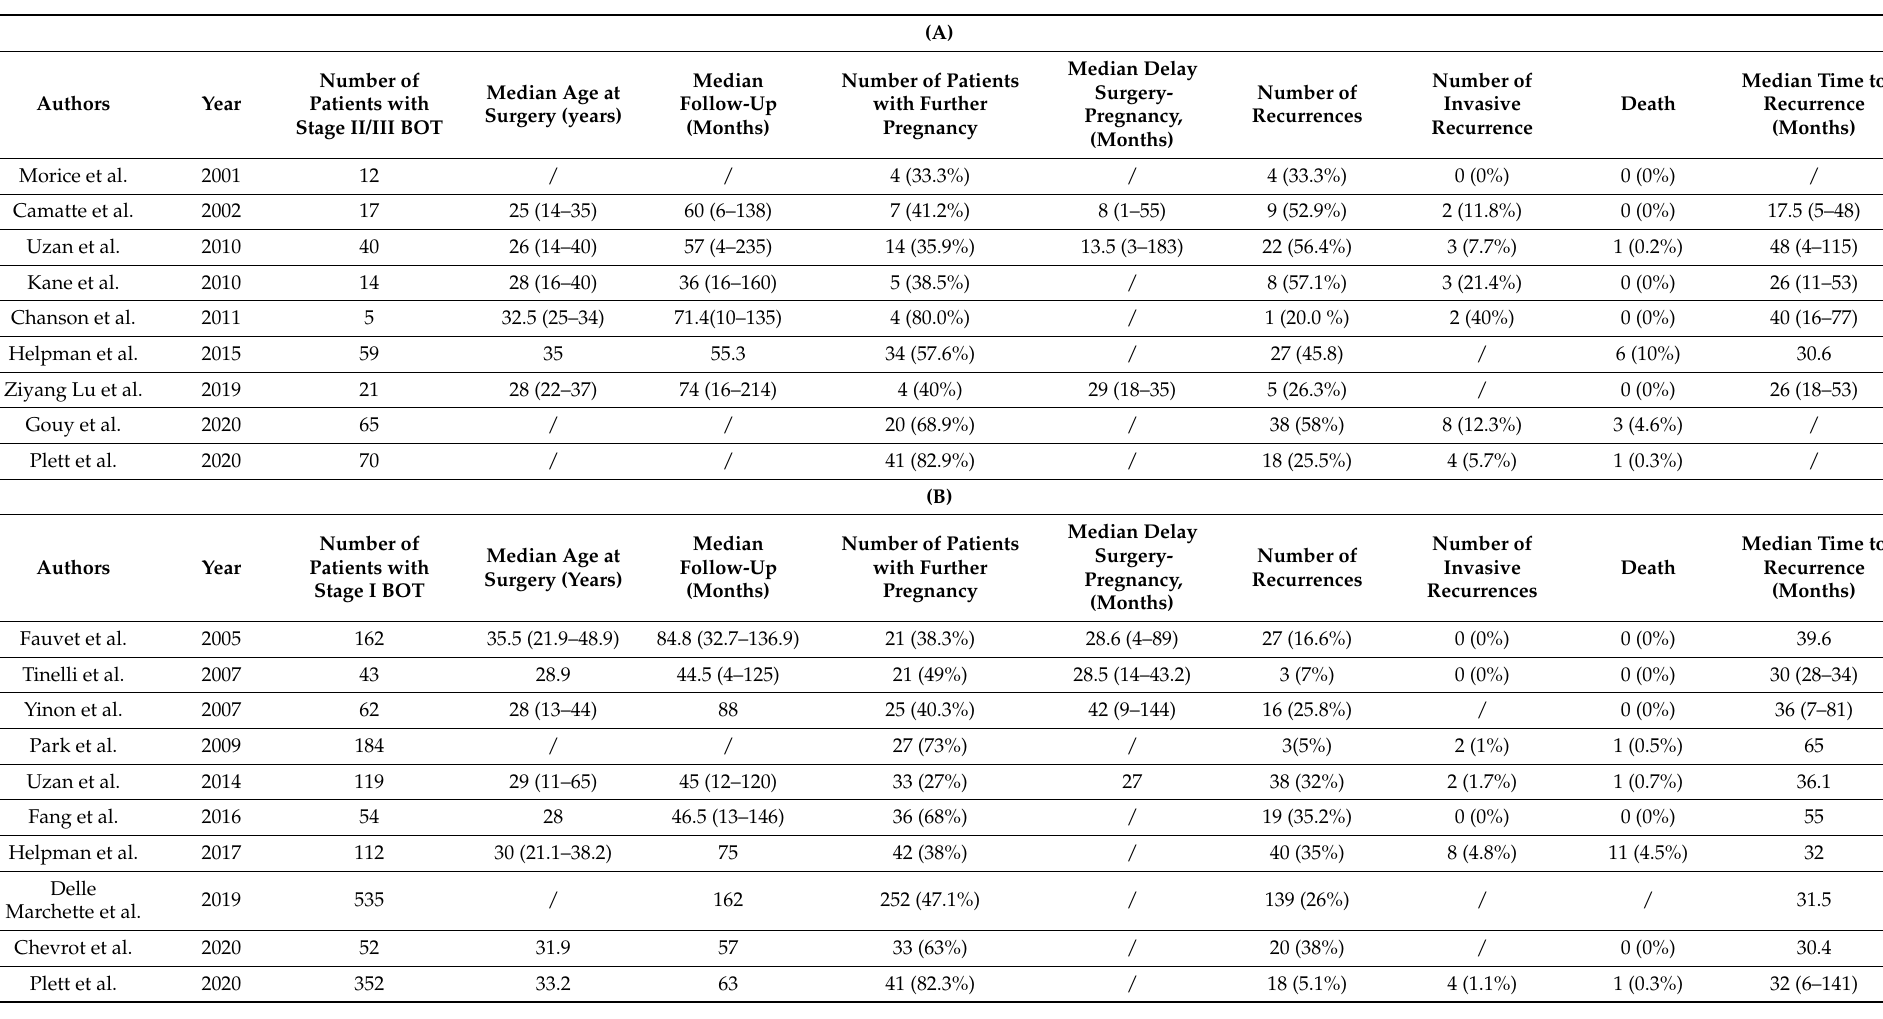
Table 6. ( A ) literature review of oncological results and fertility of patients with advanced stage of serous BOT after conservative surgery. ( B ) literature review of oncological results and fertility of patients with early stages serous BOT after conservative